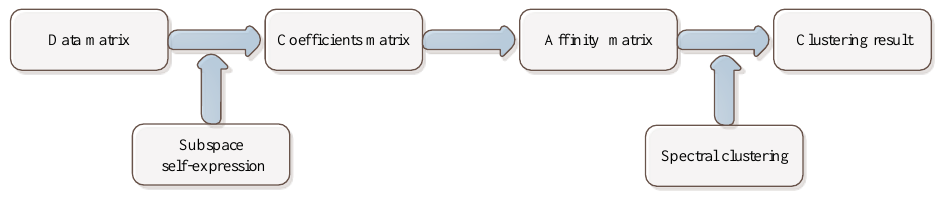
Figure 3. The basic framework of the spectral clustering-based SC